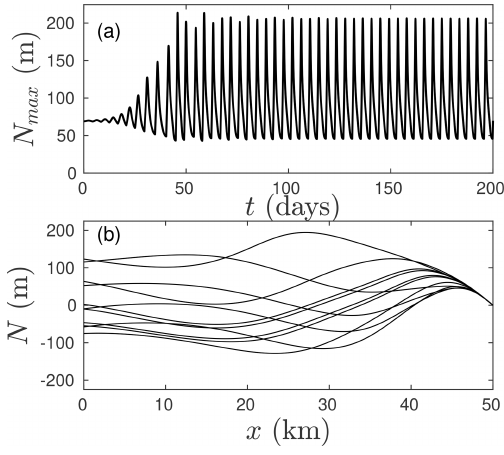
Figure 11. Finite-amplitude evolution of the instability for the ma- genta dot marked “E” in Fig. 8a. (a) The maximum of N(x,t) along the flow path plotted against time t . (b) Snapshots of N(x,t) at the same points in time as in (c)